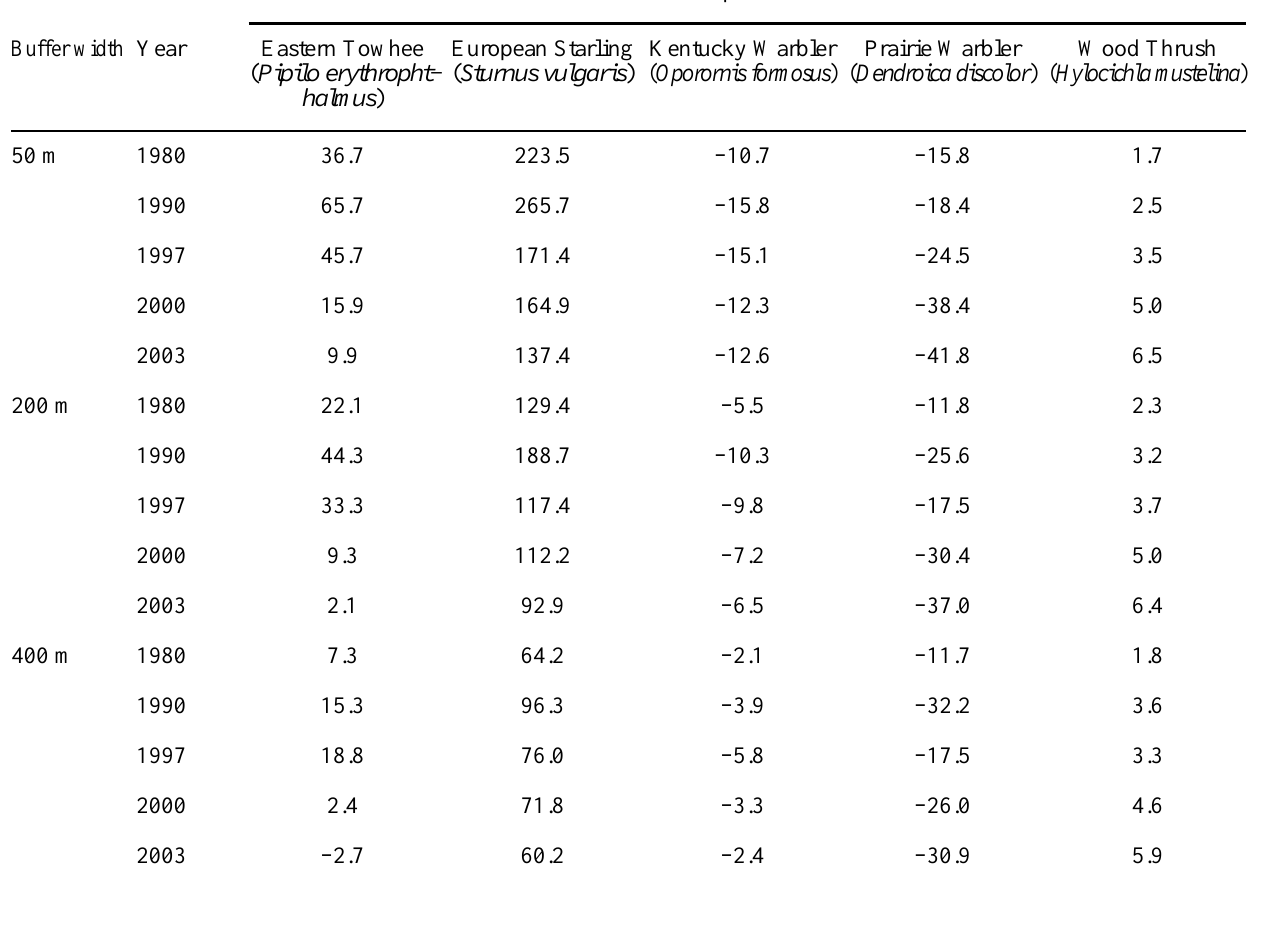
Table 6. Percentage overestimate (positive values) or underestimate (negative values) of the total population sizes of five avian species of management interest by estimates made in roadside buffers in five